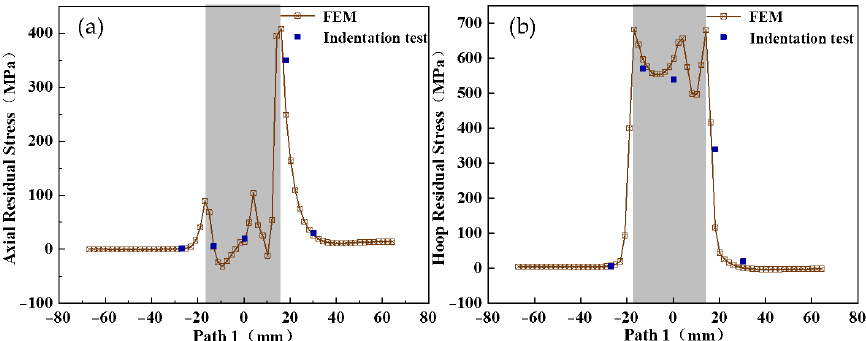
Figure 10. Residual stress distribution of path 1. ( a ) Axial residual stress, ( b ) hoop residual stress.